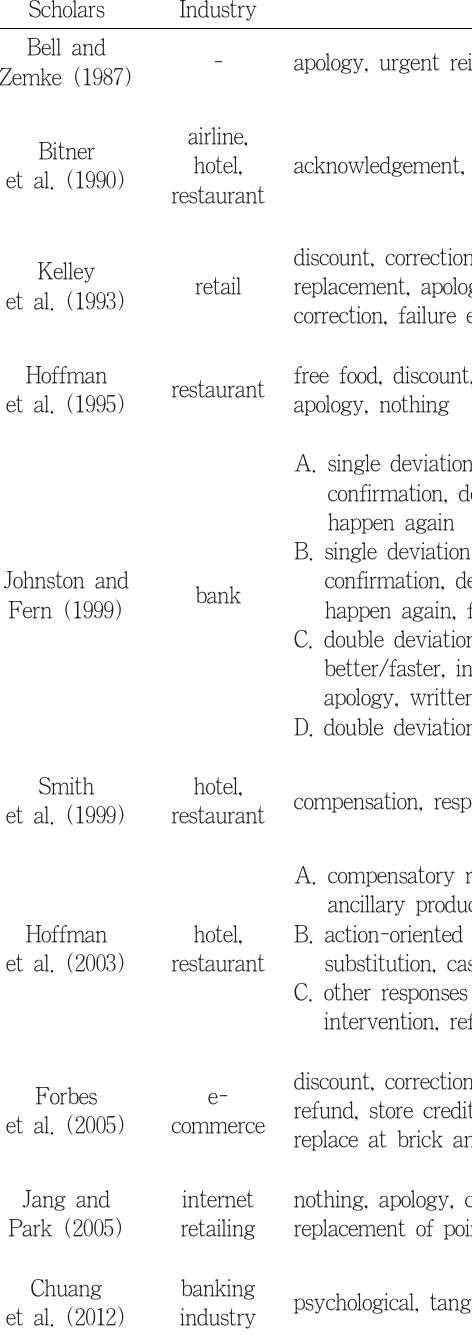
<Table 3> Service Recovery Strategy